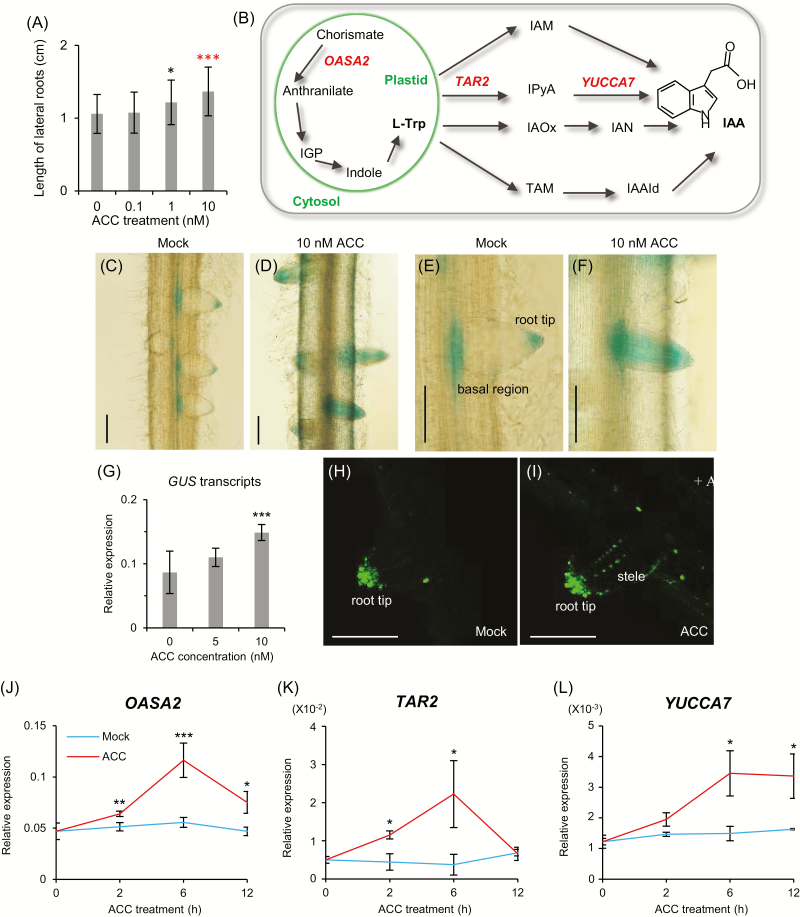
Root phenotype and expression patterns of auxin biosynthesis genes after ACC treatment. (A) Lateral root length after ACC treatment. Seedlings at 3 DAG grown on MS medium were transferred on ACC-containing medium for an additional 3 d. n>40. Statistical significance is indicated by *P<0.05 or ***P<0.001. (B) Auxin biosynthesis pathways. The tryptophan biosynthesis pathway within a circle occurs in plastids; auxin biosynthesis pathways from Trp occur in the cytosol. (C–F) DR5::GUS expression before (C and E) and after (D and F) ACC treatment. Scale bars=200 µm. (G) The GUS transcript levels after ACC treatment. For normalization, rice ubiquitin 1 (Ubi1) served as an internal control. y-axis, relative transcript level of GUS compared with that of rice Ubi1. (H and I) Patterns of DR5::GUS signals in developing lateral roots before (H) and after (I) 30 nM ACC treatment during 24 h. Scale bars=100 µm. (J–L) Expression levels of Trp-dependent auxin biosynthesis genes OASA2 (J), TAR2 (K), and YUCCA7 (L) in roots after 50 nM ACC treatment. For normalization, rice Ubi1 served as an internal control. n=4. Statistical significance is indicated by * (P<0.1), ** (P<0.05), and *** (P<0.01).